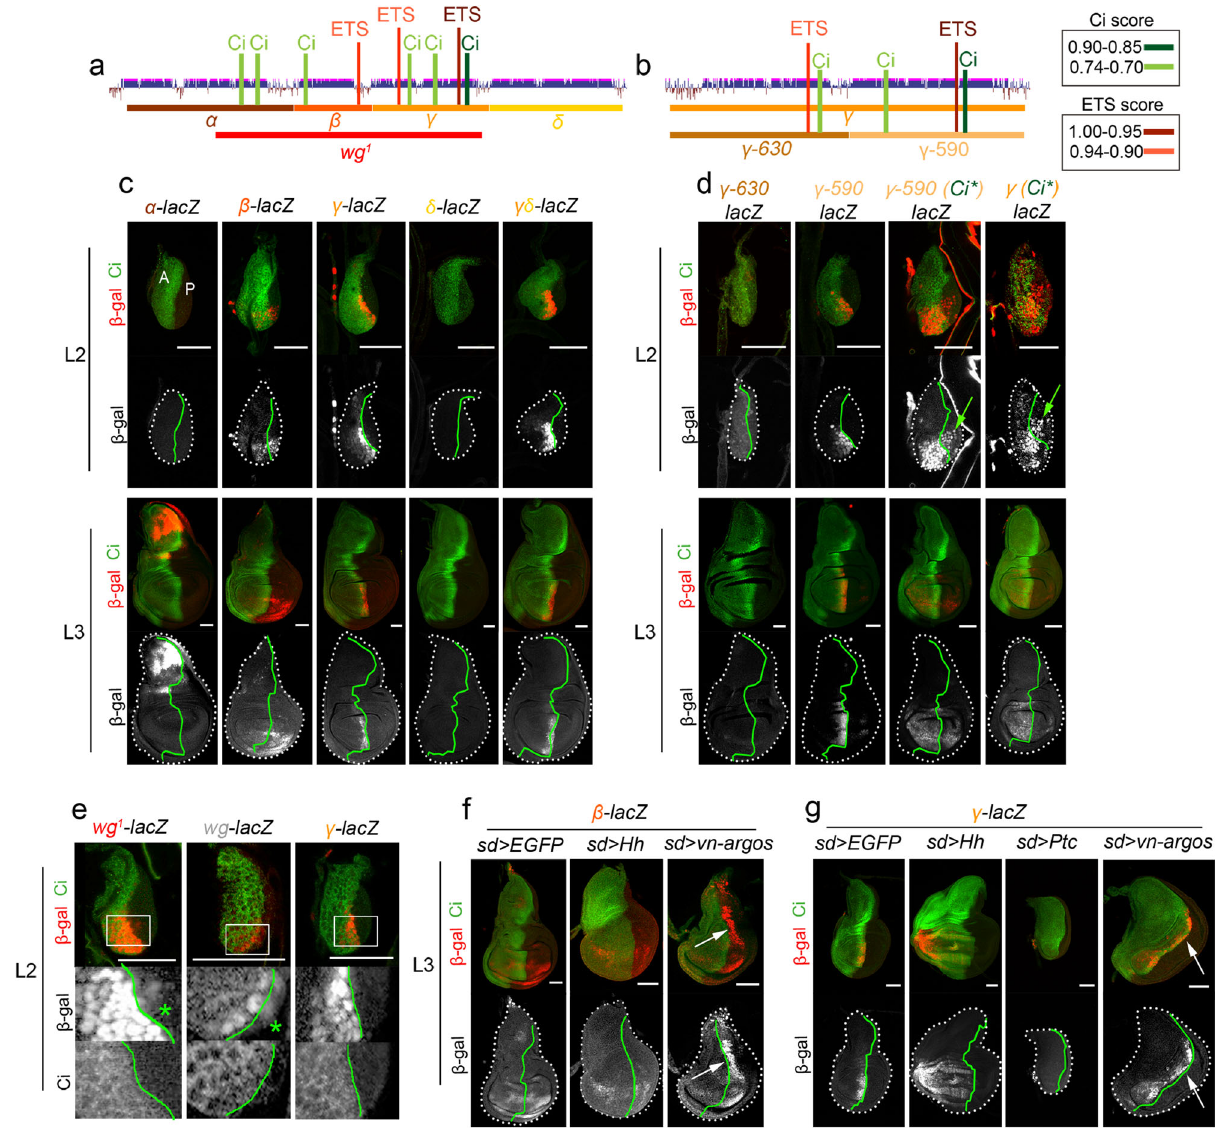
Fig. 3 | Two independent CRMs within the wg 1 -enhancer. a , b Cartoons depicting the evolutionarily conserved modules spanning the wg 1 -enhancer and the presence of bioinformatically predicted Ci (in green) and ETS (in red) binding sites with the scores shown in the table. c – g Second (L2) and late third (L3) instar wing imaginal discs of larvae bearing the indicated reporters and stained for ß-galactosidase (red or white) and Ci (green). Green arrows in ( d )